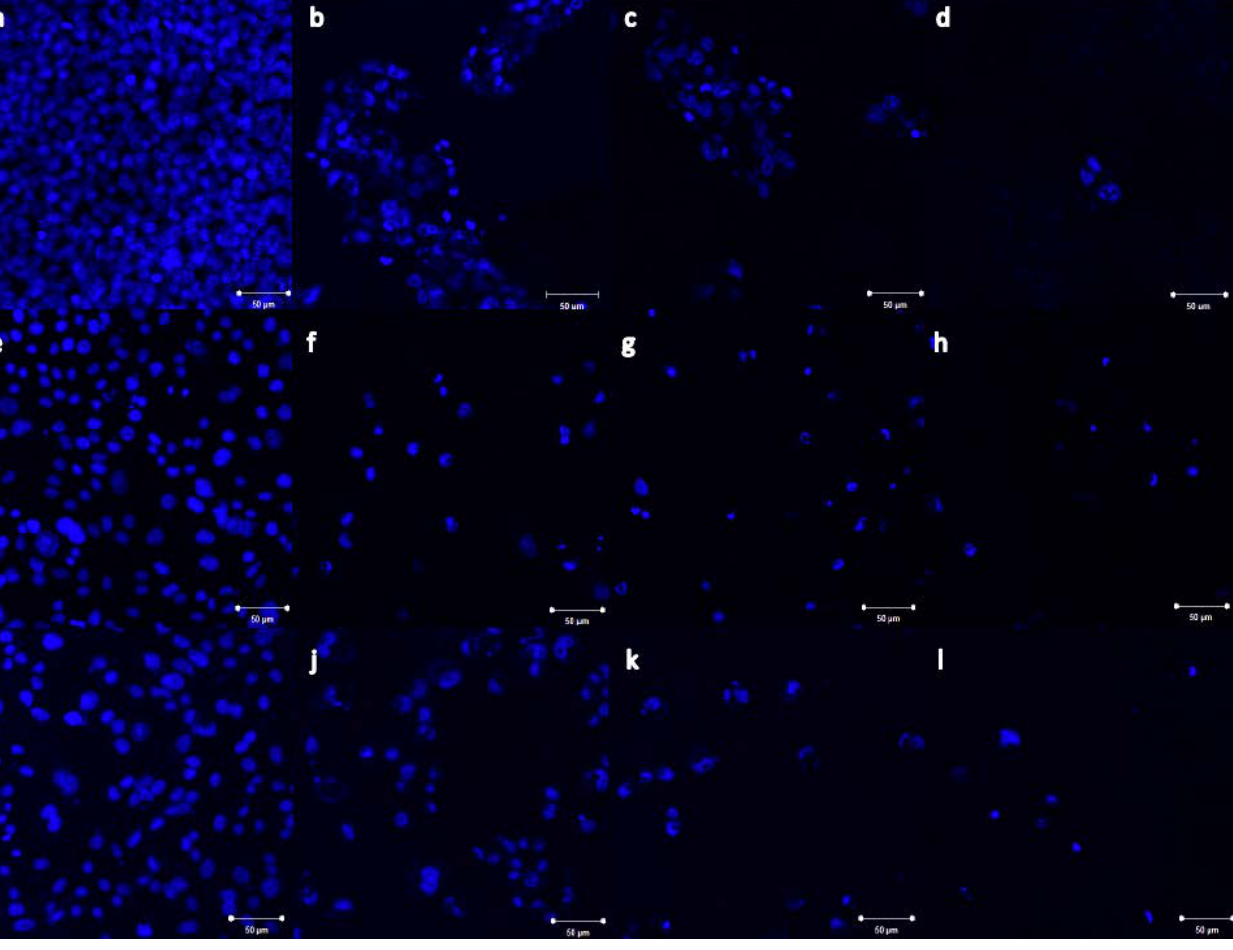
Figure 10. Confocal microscopic images of MCF-7, HCT116 and HeLa cells treated with β -Nb 2 ZnO 6 nanoparticles ( A ). The cells were treated for 48 h with 0.25, 0.5, and 1 mg/mL of β -Nb 2 ZnO 6 ( A ) nanoparticles. ( a ) Untreated MCF-7 cells, ( b – d ) MCF-7 cells treated with 0.25, 0.5 and 1 mg/mL of β -Nb 2 ZnO 6 ( A ), respectively. ( e ) Untreated HCT116 cell, ( f – h ) HCT116 cells treated with 0.25, 0.5 and 1 mg/mL of β -Nb 2 ZnO 6 ( A ), respectively. ( i ) Untreated HeLa cells, ( j – l ) HeLa cells treated with 0.25, 0.5 and 1 mg/mL of β -Nb 2 ZnO 6 ( A ), respectively. The blue tint signifies DAPI-stained cell nuclei (200 × magnification, scale bar is 50 µ m for all